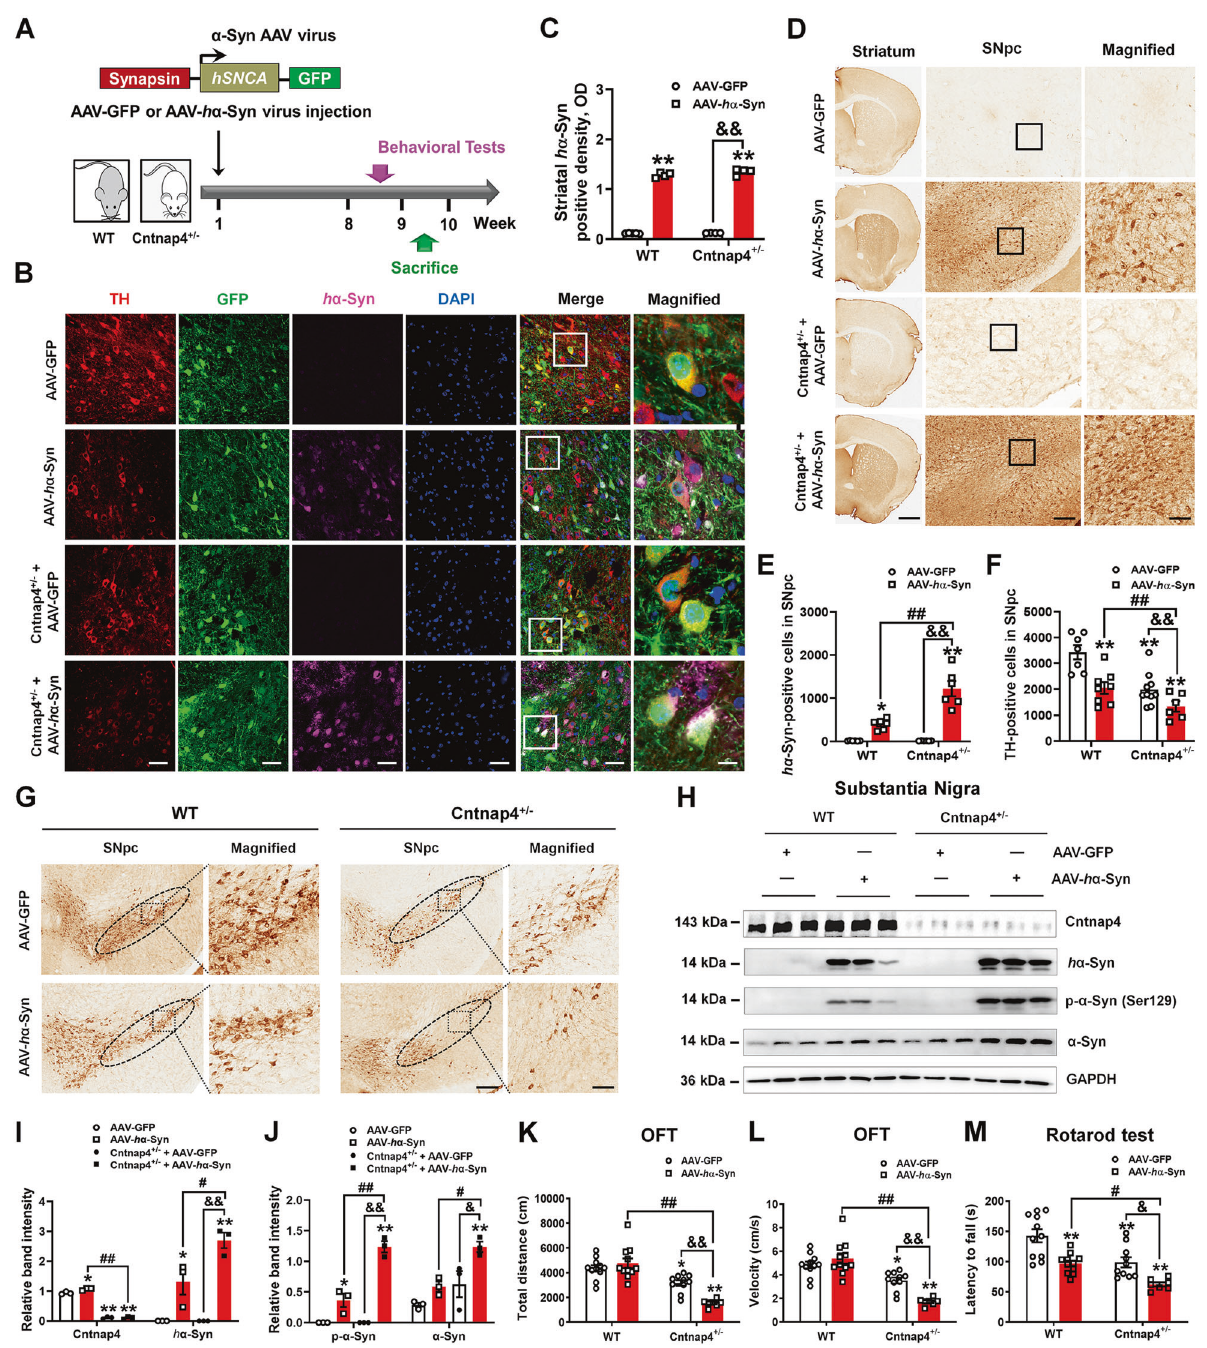
Fig. 1 Cntnap4 partial de fi ciency exacerbates α -synuclein pathology, nigral DA neuronal death, and motor dysfunction. A Schematic model of the study design. B Immuno fl uorescence staining of TH and h α -Syn in the SNpc of WT and Cntnap4 + / − mice injected with either AAV-GFP or AAV- h α -Syn. Scale bars: 40 μ m. Magni fi ed co-staining of TH and h α -Syn-positive cells in the SNpc are shown in the right column of panel B . Scale bars: 8 μ m. C – E Immunohistochemical staining and quanti fi cation of h α -Syn density and positive cells in the striatum and SNpc of WT and Cntnap4 + / − mice injected with either AAV-GFP or AAV- h α -Syn. Scale bars: 1 mm in the striatum and 100 μ m in the SNpc. Magni fi ed images of h α -Syn-positive cells in the SNpc are shown in the right column of panel D . Scale bars: 50 μ m. n = 4 – 6. F , G Immunohistochemical staining and quanti fi cation of TH-positive cells in the SNpc of WT and Cntnap4 + / − mice injected with either AAV-GFP or AAV- h α -Syn. Scale bars: 100 μ m. Magni fi ed images of TH-positive cells in the SNpc are shown in the right column of panel G. Scale bars: 50 μ m; n = 6 – 10. H – J The protein expression levels of Cntnap4, h α -Syn, phosphorylation of α -synuclein at serine 129, and mouse α -synuclein were determined by western blotting; n = 3 per group. K , L Total distance traveled and movement speed in the open- fi eld of WT and Cntnap4 + / − mice injected with either AAV-GFP or AAV- h α -Syn. M The rotarod test was used to examine the motor coordination of mice; n = 11, 11, 10, and 7 in the WT + AAV-GFP, WT + AAV- h α -Syn, Cntnap4 + / − + AAV-GFP, and Cntnap4 + / − + AAV- h α -Syn groups, respectively. Results are expressed as the mean ± SEM. ** p < 0.01, * p < 0.05 vs . WT; ## p < 0.01, # p < 0.05 vs. AAV- h α -Syn; && p < 0 . 01, & p < 0.05 vs. Cntnap4 + / − . Statistical signi fi cance was determined using two-way ANOVA + Bonferroni ’ s multiple comparisons test.